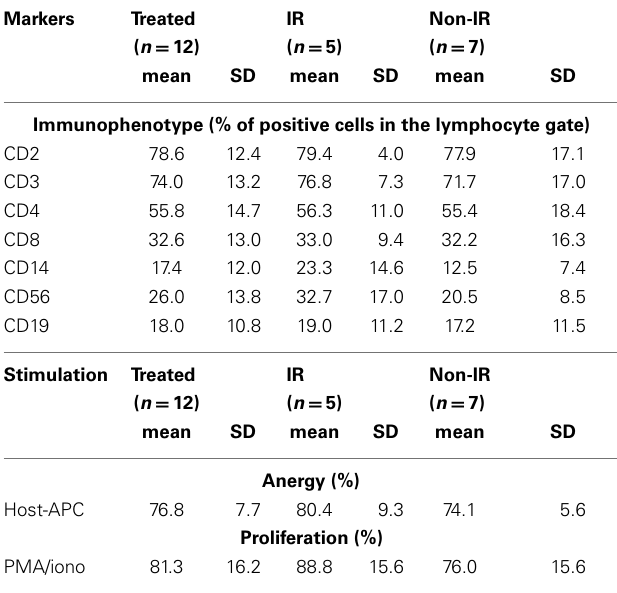
Table 2 | Immunophenotype and function of IL-10-DLI infused in patients of theALT-TEN trial